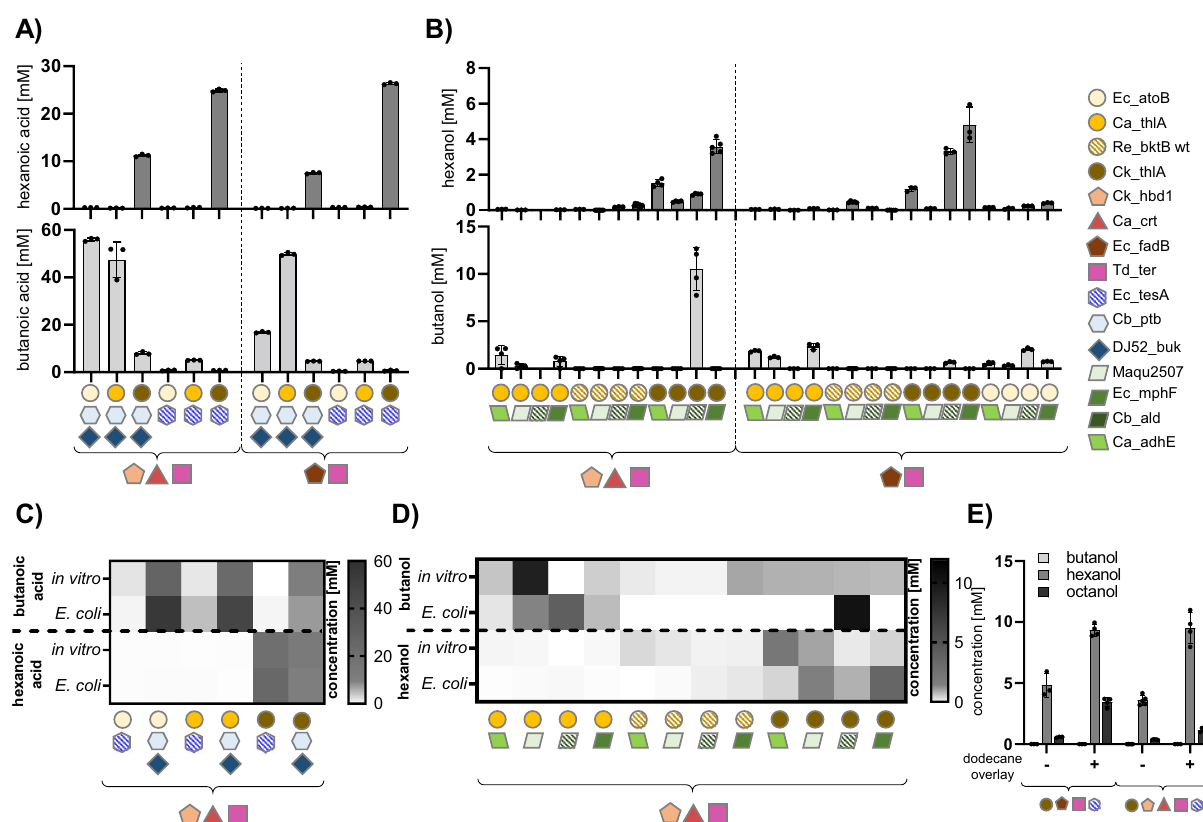
Fig. 4 Testing r-BOX variants in E. coli . A Quanti fi cation of butanoic and hexanoic acid production in E. coli strains containing newly identi fi ed core enzymes (left) or previously characterized enzyme combination (right). B Quanti fi cation of butanol and hexanol production in E. coli strains containing newly identi fi ed core enzymes (left) or previously characterized enzyme combination (right), various thiolases and a range of ACR-ADH or AdhE termination enzymes. C Direct comparison of in vitro (see Fig. 3A) and E. coli butanoic and hexanoic acid production (see A ). D Direct comparison of in vitro (see Fig. 3B) and E. coli butanol and butanoic acid production (see B ). E Strains containing Ck_thlA and Ec_tesA as well as the previously characterized old core enzymes (left) or new core enzymes (right) with or without a dodecane organic overlay. Assays were run in at least triplicates ( n > 3) and all data points and their mean are shown. Error bars represent standard deviation. Detailed results and full information on enzyme abbreviations in Source Data fi